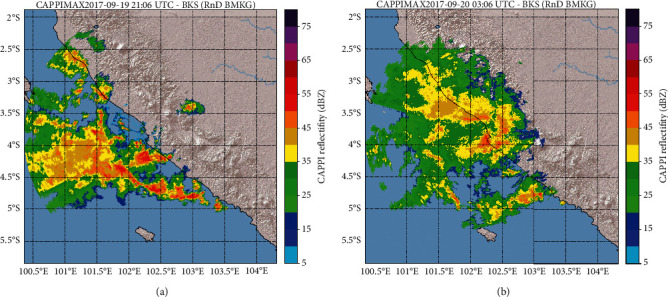
The maximum of the CAPPI reflectivity of Bengkulu Radar. (a) CAPPIMAX represents that the MCS was located in the Indian Ocean on 19th September 2017 at 21 : 06 UTC (20th September 2017 at 04.06 LT) and (b) the MCS was located in Bengkulu Province on 20th September 2017 at 03 : 06 UTC (20th September 2017 at 10 : 06 LT).